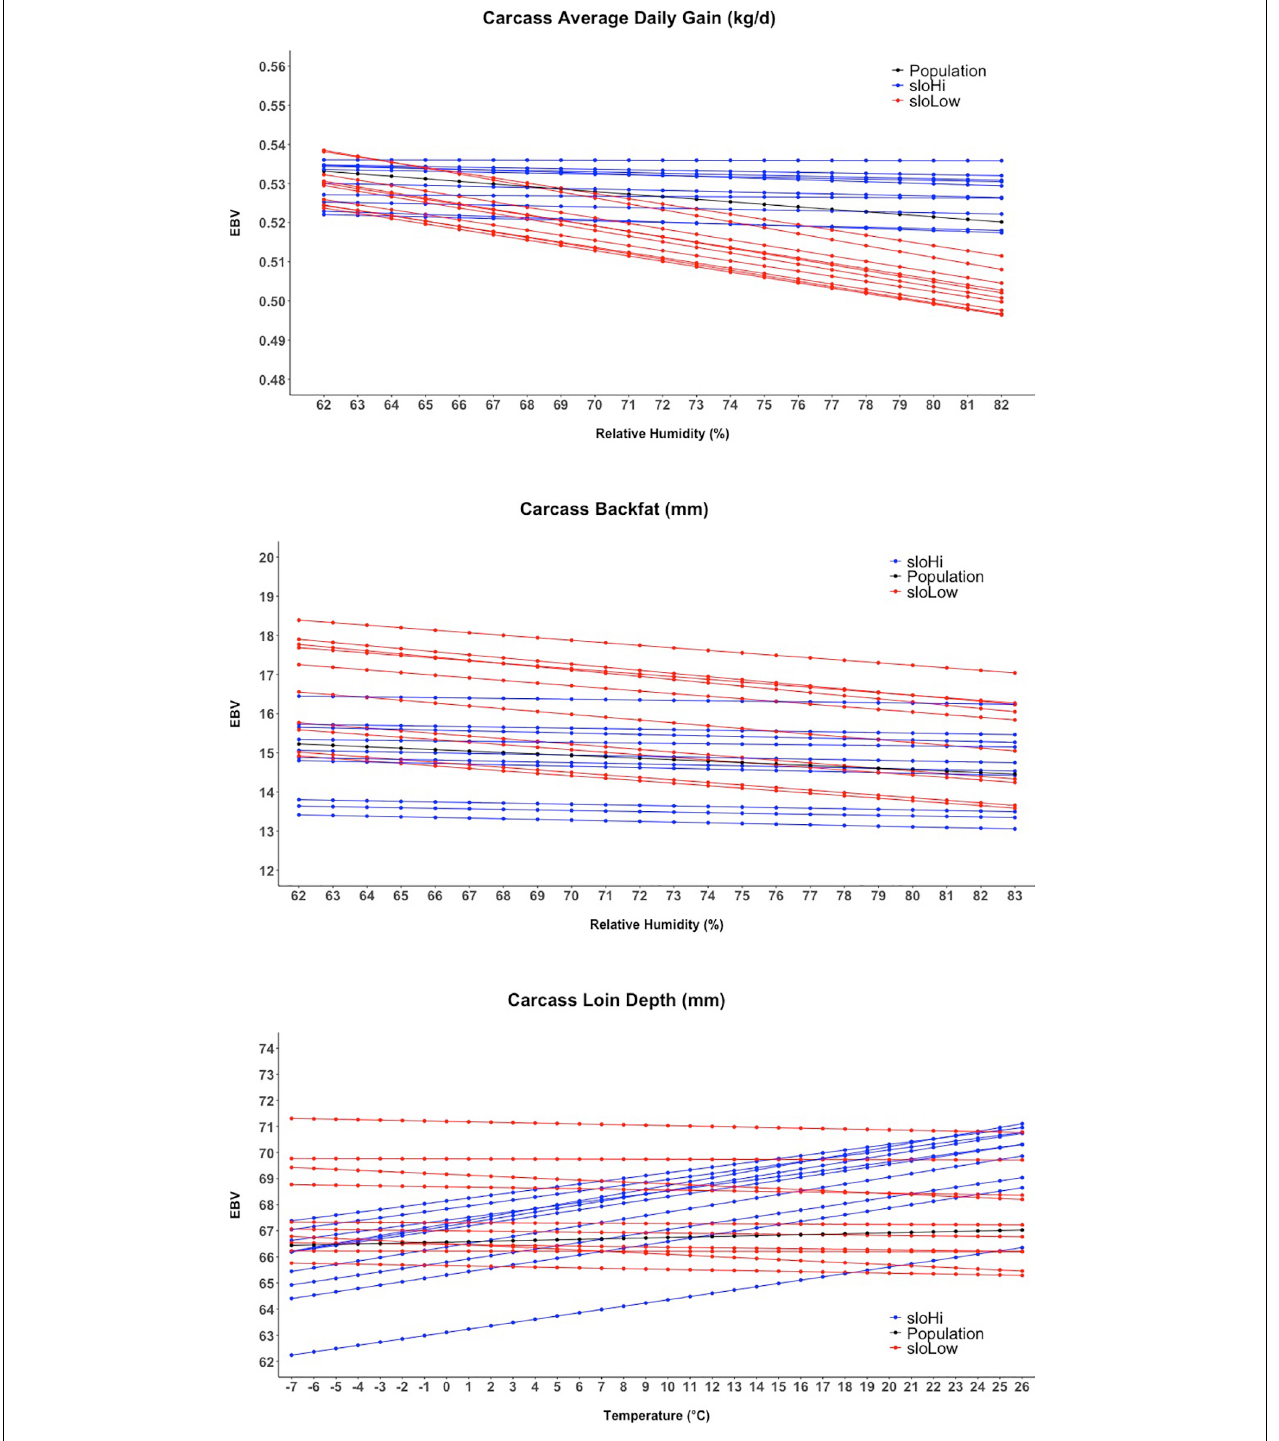
FIGURE 5 | Reaction norms for the twenty sires showing the higher and lower estimated breeding values (EBV) for the slope term of the random regression model.